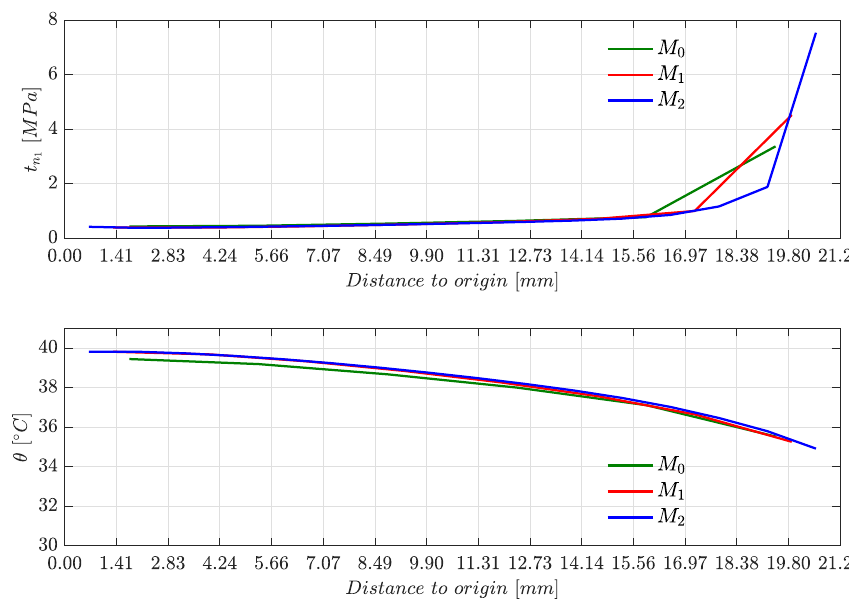
Figure 7. Discretization influence on the normal contact traction and temperature values at the nodes located at the diagonal of the contact zone for: M 0 = 72 elements, M 1 = 128 elements and M 2 = 512 elements.